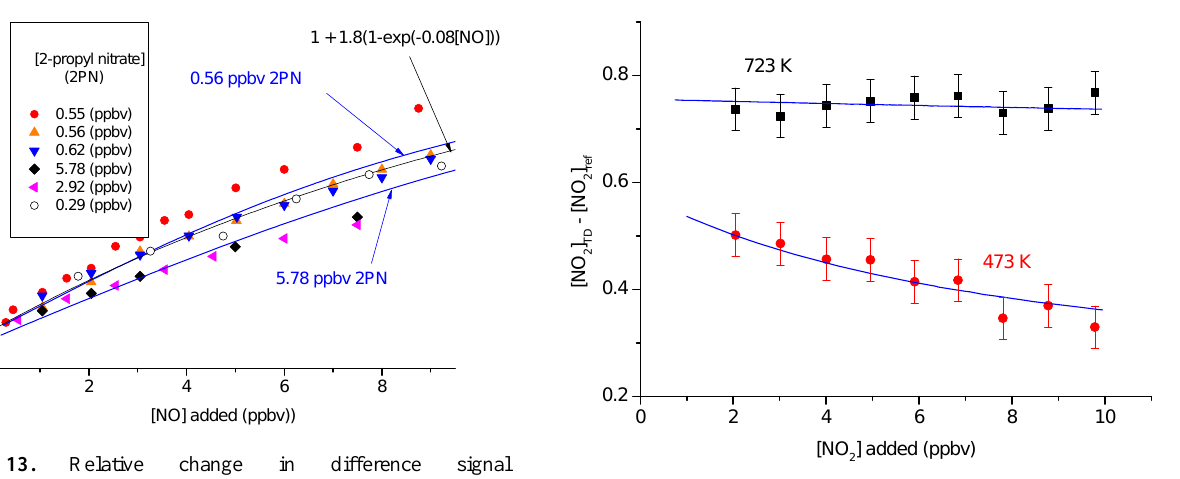
Figure 14. Dependence of ([NO 2 ] TD 473 − [NO 2 ] ref ) and ([NO 2 ] TD723 − [NO 2 ] ref ) on added NO 2 in the presence of PAN (0.53ppbv) and AN (0.19ppbv). The error bars represent standard deviation and were derived by propagating errors in the NO 2 signals in the TD and reference cavities. The blue lines show the model results as described in the